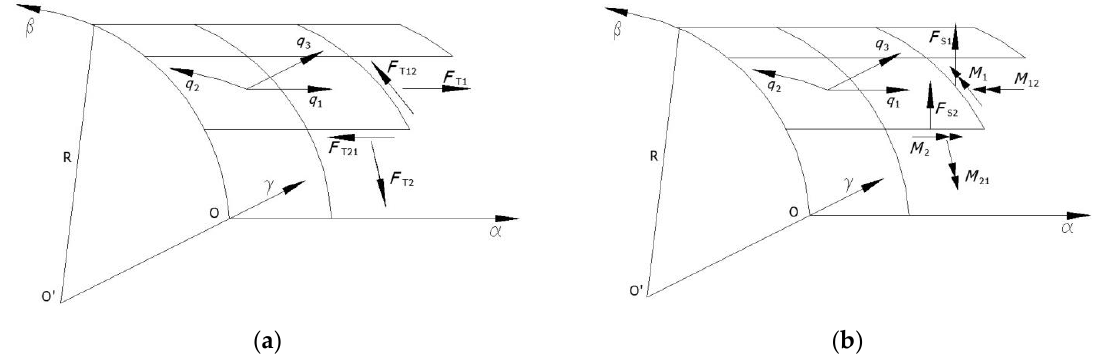
Figure 3. Curvilinear coordinate system for the cylindrical shell and internal forces. ( a ) Membrane internal forces. ( b ) Bending internal forces.